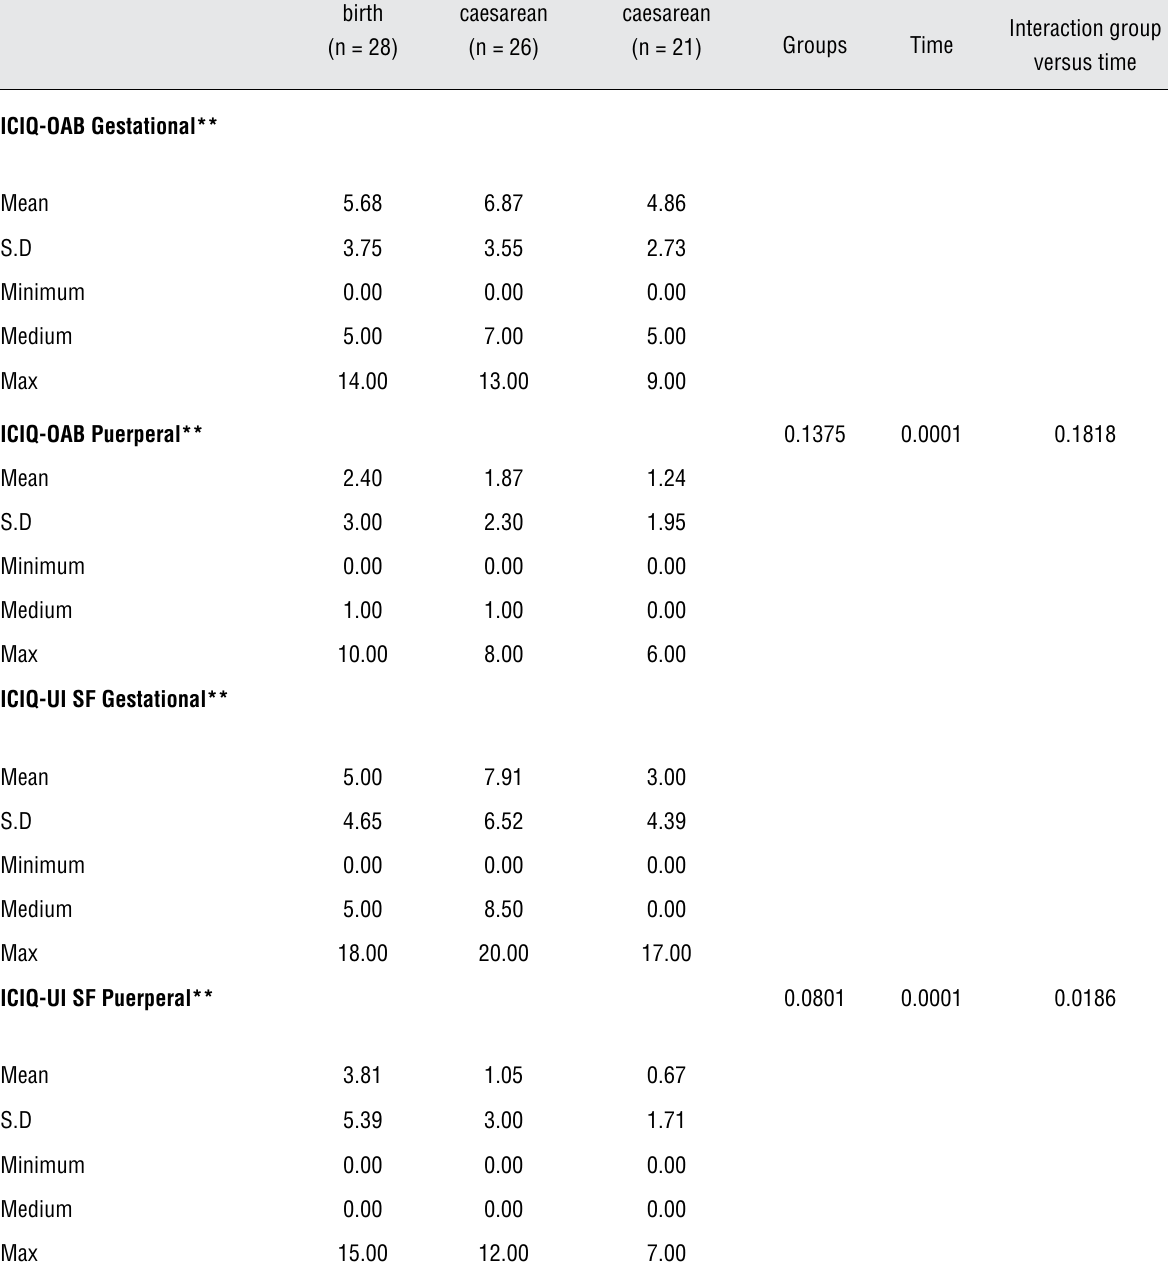
P-value: the table represents comparison among the studied groups (vaginal birth, elective and emergency cesarean); the comparison between the evalu- ation time (gestational evaluation and puerperal reevaluation); and interaction between both (groups versus time). S.D: Standard